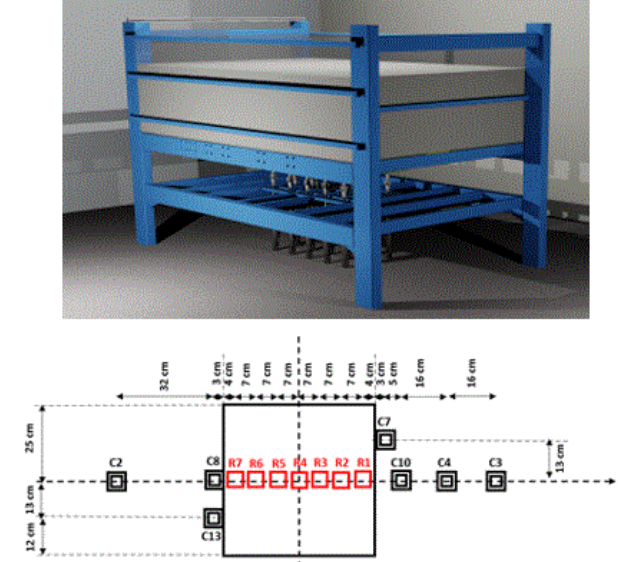
Figure 1. Description of the 3D-1g physical model and location of the radars “R” and of the pressure measurement cells “C”.